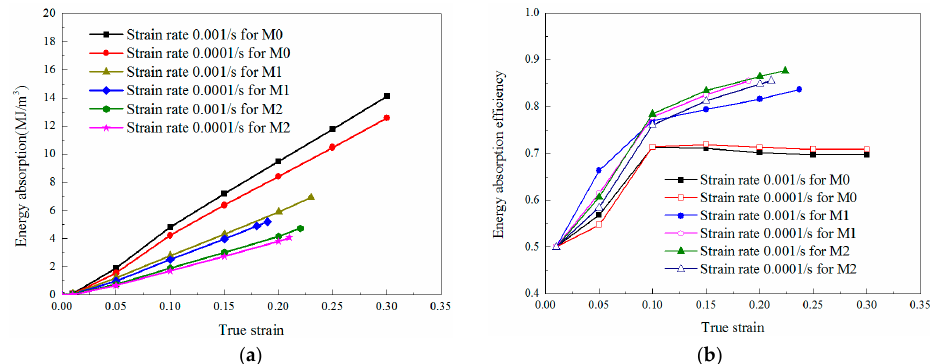
Figure 5. Energy absorption performance of epoxy resin specimens with different content of LNBR: 0% (M0), 10% (M1), 25% (M2) under quasi-static strain rates. ( a ) Energy absorption; ( b ) energy absorption efficiency.